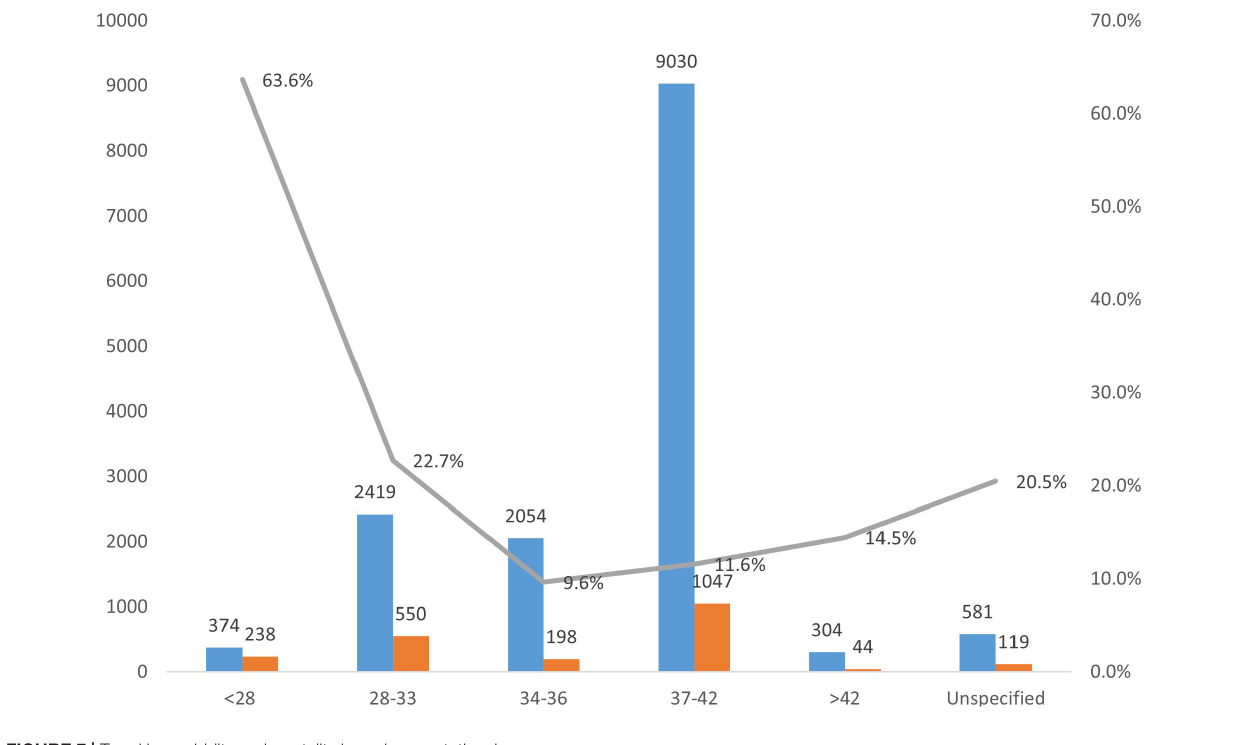
FIGURE 7 | Trend in morbidity and mortality based on gestational